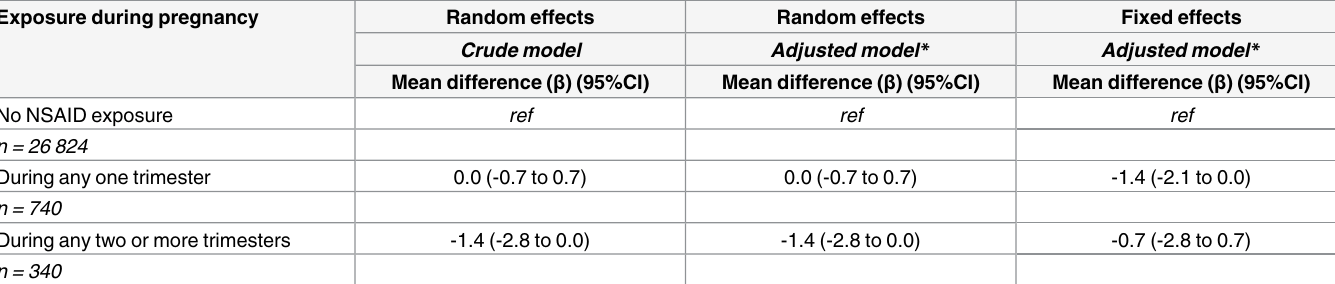
(Table 5). The sensitivity analysis on term infants did not change the effect estimates for timing as shown in S1 Table or duration of exposure as shown in S2 Table.